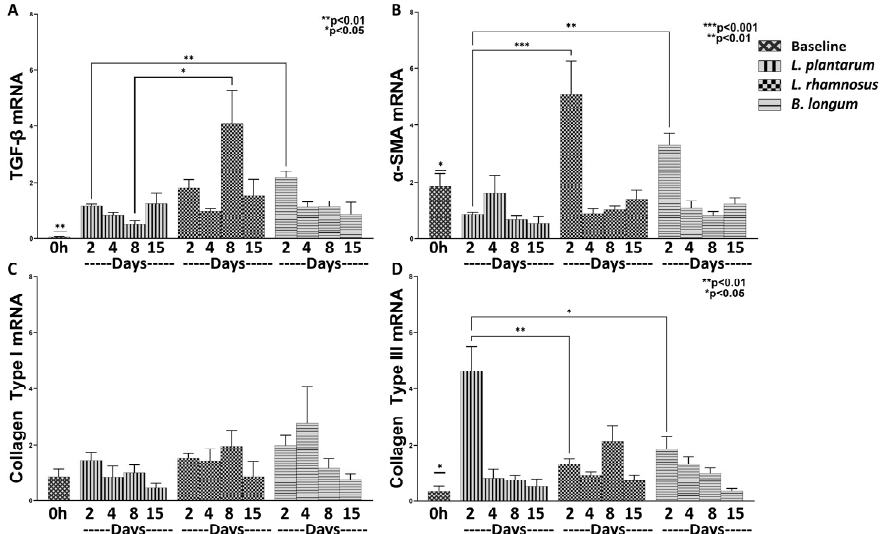
Figure 5. The effects of L. plantarum , L. rhamnosus and B. longum on the wound healing